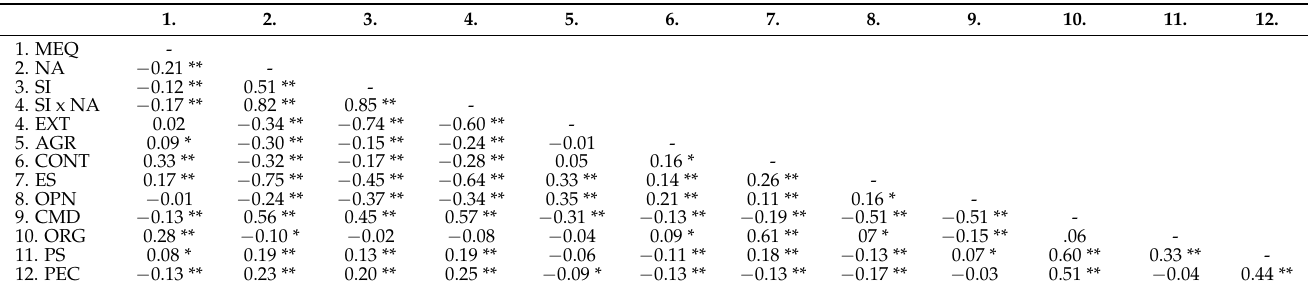
Table 2. Correlations between chronotype preference and personality traits.